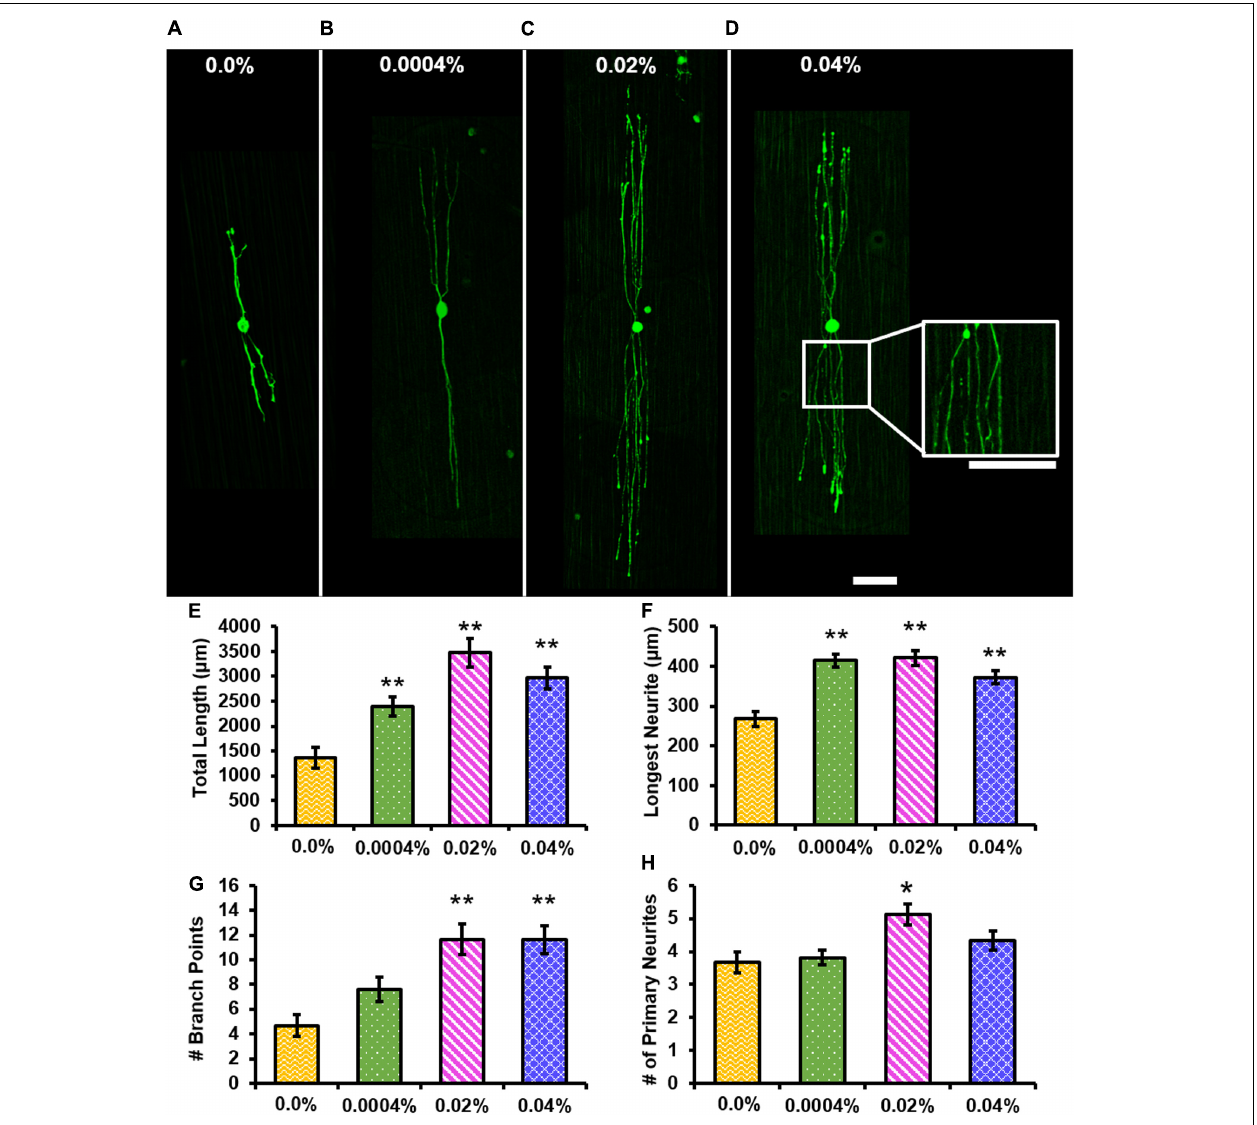
FIGURE 6 | The addition of fingolimod to poly(lactic-co-glycolic acid) (PLGA) electrospun fibers affects neurite outgrowth from individual dorsal root ganglia (DRG) neurons. Confocal images of individual DRG neurons stained against neurofilament (green) and cultured for 12 h on (A) 0.0%, (B) 0.0004%, (C) 0.02%, or (D) 0.04% fingolimod-loaded PLGA electrospun fibers (scale bar = 100 µ m). (E) Total neurite length (in µ m), (F) longest neurite length (in µ m), (G) the number of branch points, and (H) the number of primary neurites data are represented by the mean ± standard error of the mean. Statistical significance compared with the 0.0% control fibers was assessed for total neurite length, longest neurite length, and the number of branch points data using Welch’s ANOVA and post hoc Games–Howell test and for the number of primary neurites using one-way ANOVA and post hoc Dunnett’s test (** p < 0.001, * p < 0.05).